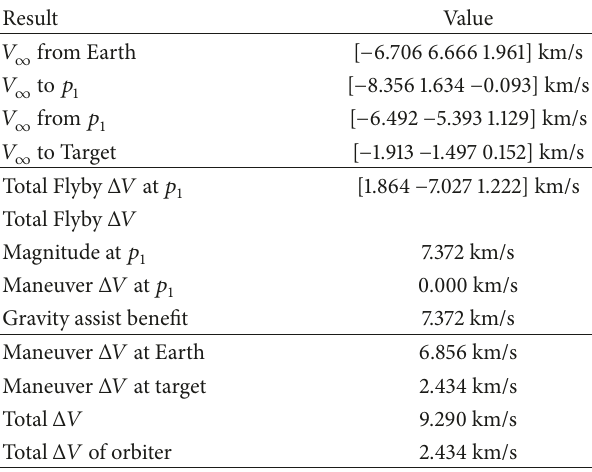
Table 8: Single planet flyby results from Earth to Hylonome.